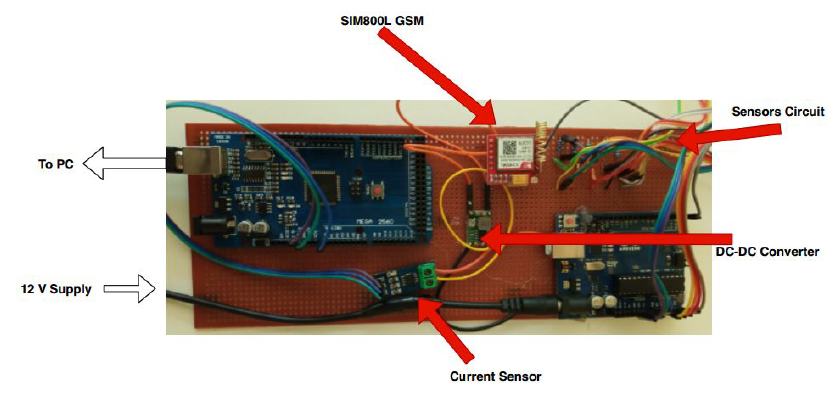
Figure 3. Internal circuity of the